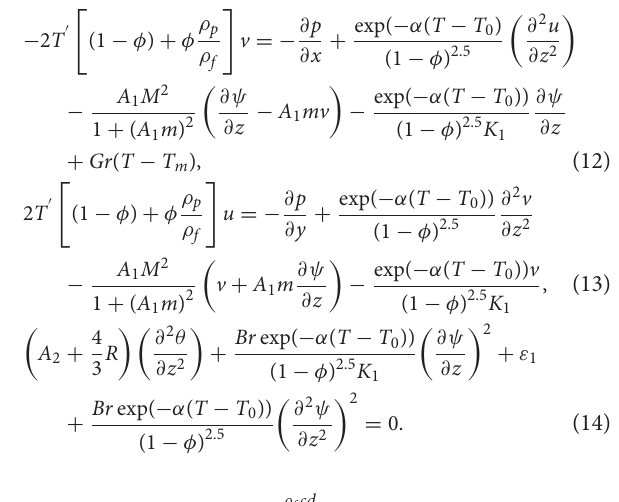
Frontiers in Physics |